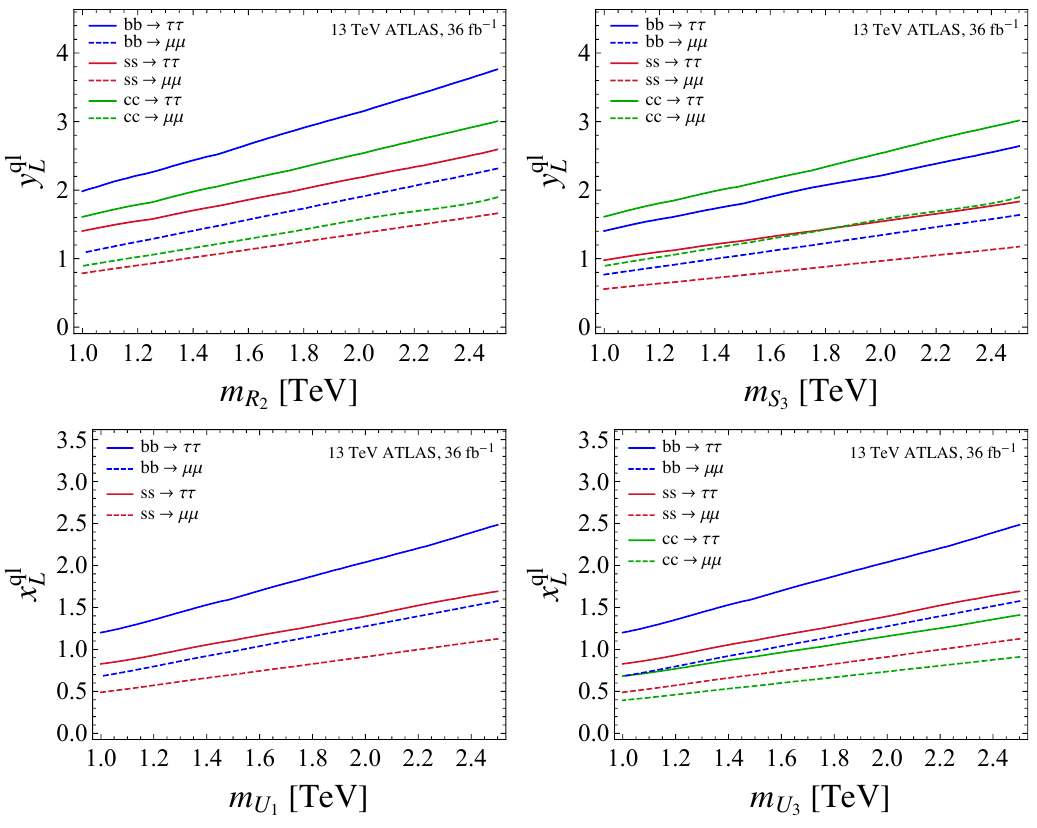
Figure 4 . The top panel (lower panel) shows current limits in the coupling vs mass plane for several scalar LQ (vector LQ) models from LHC searches in pp ! ‘ (cid:22) ‘ high- p T tails at 13 TeV with 36 fb (cid:0) 1 of data. The solid and dashed lines represent limits from di-tau and di-muon searches, respectively, for di(cid:11)erent initial quarks while turning one scalar (vector) LQ coupling y ql a